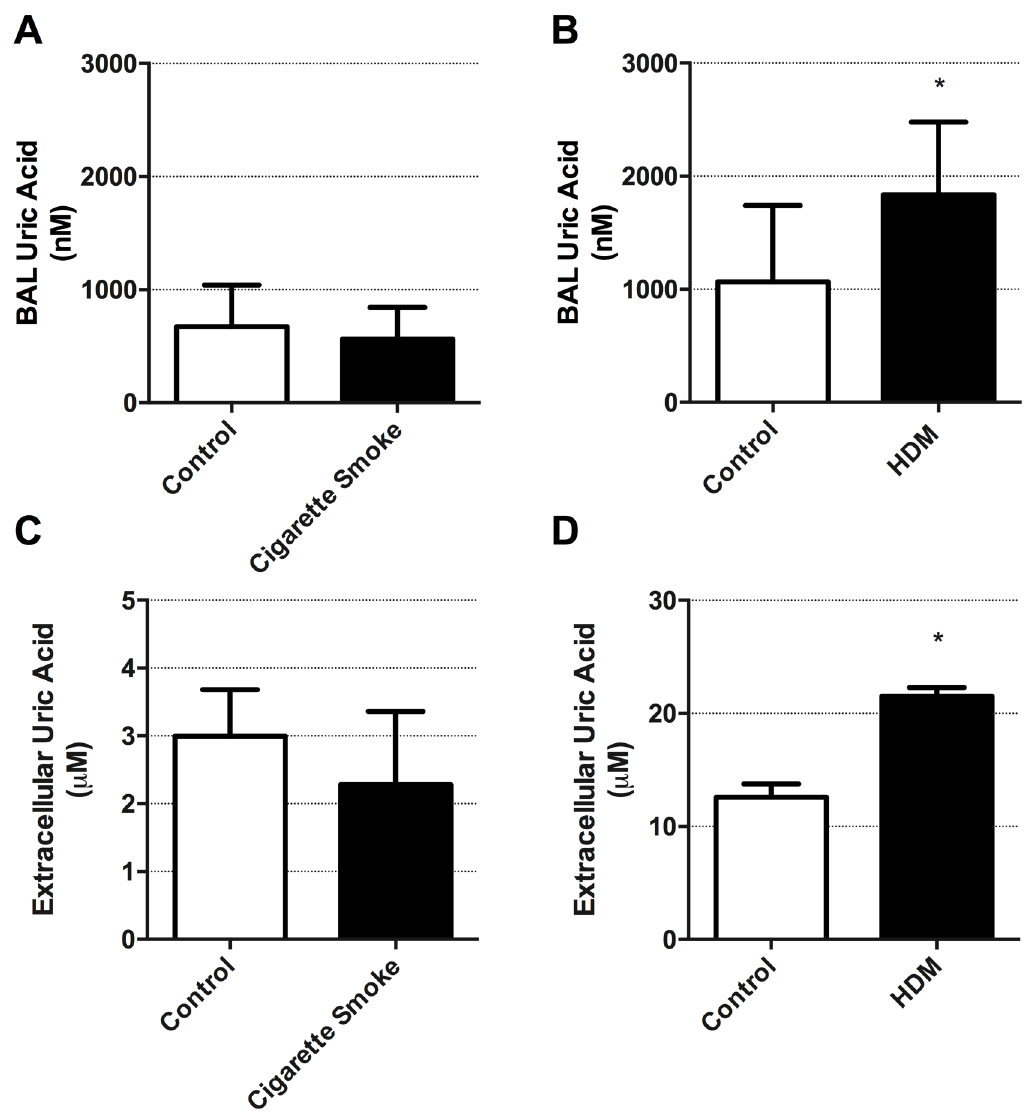
Fig 1. Exposure to HDM but not cigarette smoke induces uric acid production in vivo in mouse lungs and in vitro in human airway epithelial cells. ( A ) BAL analysisof uric acid levels in mice 24h followingexposure to air or cigarette smoke (n = 10). ( B ) BAL analysisof uric acid levels in mice 24h followingexposureto PBS or HDM (n = 10). ( C ) HBEC-6KT human airway epithelialcell culture supernatant analysisof uric acid levels 24h followingexposureto control (media alone)or cigarette smoke (4% cigarette smoke extract conditioned media) (n = 6). ( D ) HBEC-6KT human airway epithelialcell culture supernatantanalysisof uric acid levels 24h followingexposure to control (PBS) or HDM (50 μ g/ml) (n = 6). Data represent mean +/- SD. Significance is representedby * = p < 0.05relativeto